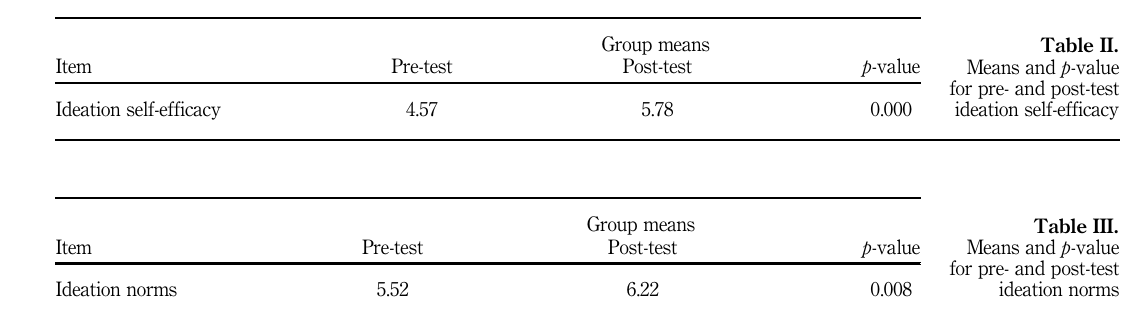
Table II. Means and p -value